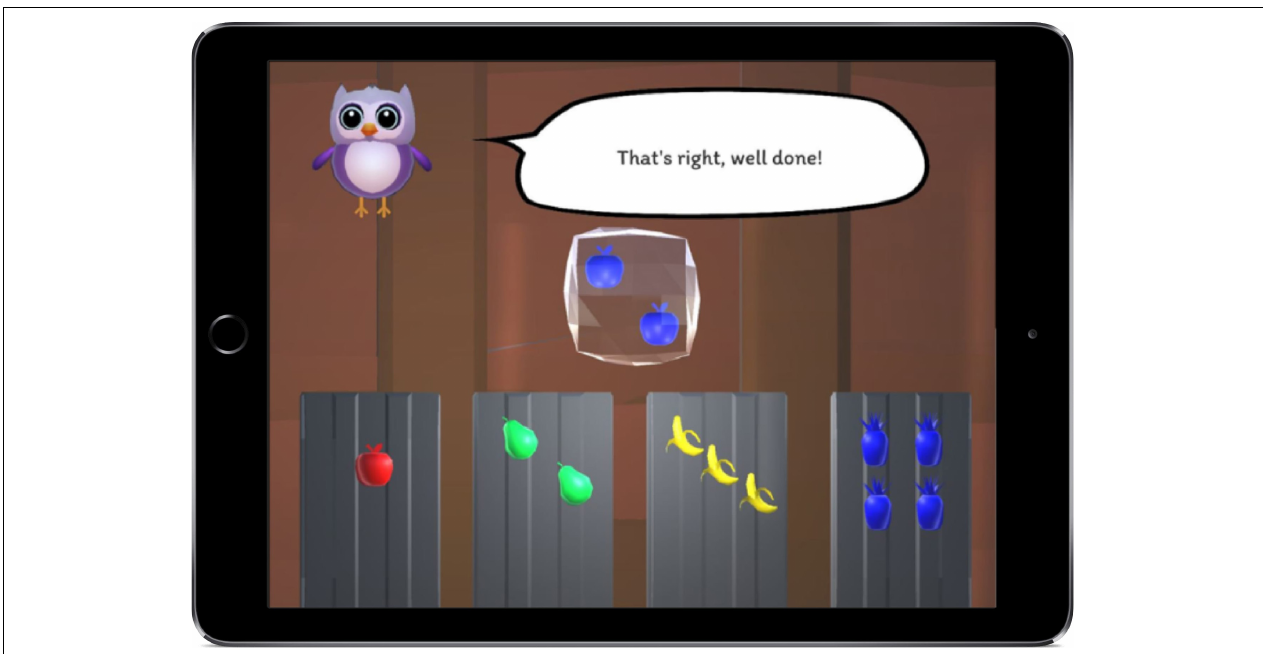
FIGURE 4 | The eFun cognitive flexibility game showing the ice cube that needs to be sorted into one of the tubes. If the correct rule was “color” the cube would need to be sorted into the very right tube, for the rule “shape” it would need to be sorted into the very left tube and for the rule “number” it would need to be sorted into the second tube from the